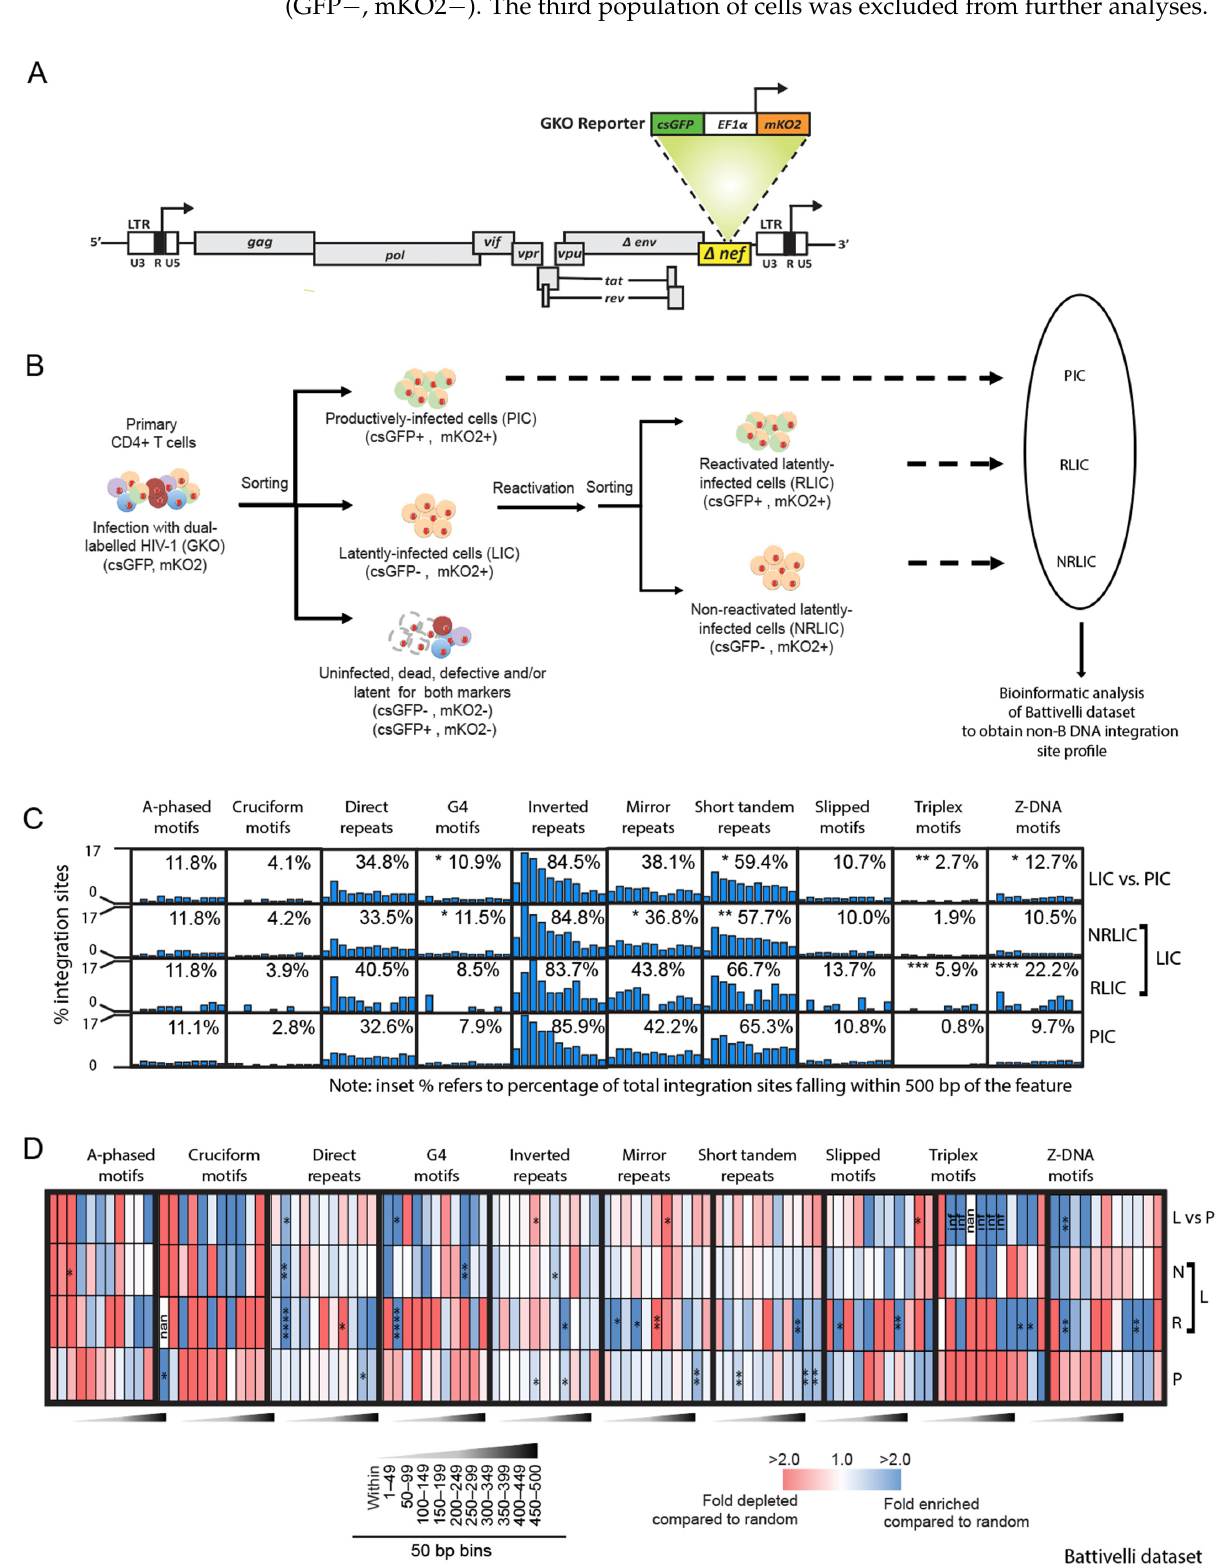
Figure 1. Integration near specific non-B DNA is associated with proviral reactivation in latently infected cells. ( A ), Schematic depicting the HIV-1 vector used to generate productively and